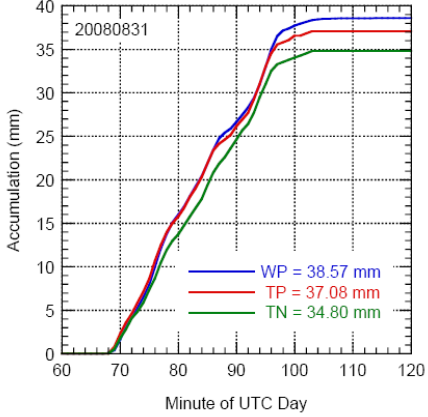
Fig. 9 One-minute rain accumulations at Norman, OK, August 31, 2008 for the three Fig. 9. One-min rain accumulations at Norman, OK, 31 Au- gauges. gust 2008 for the three gauges.